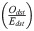
Standardized incidence ratio OdstEdst for HIV.